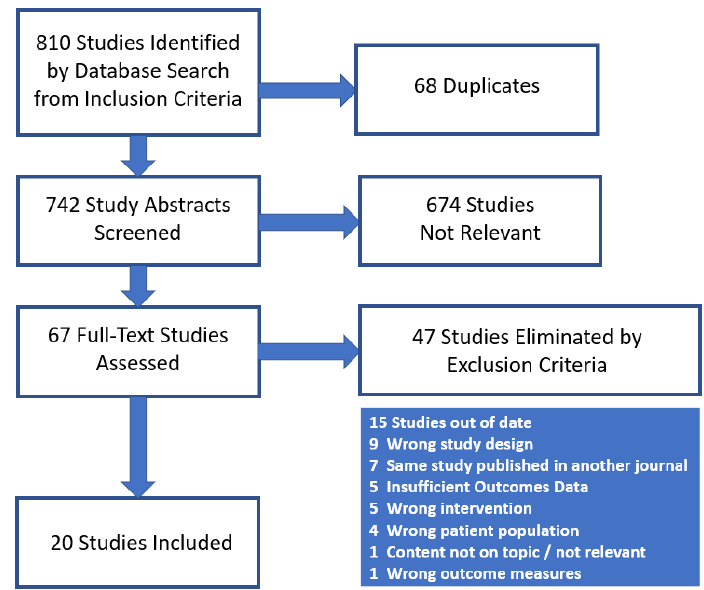
Figure 1. PRISMA flow chart for study selection.